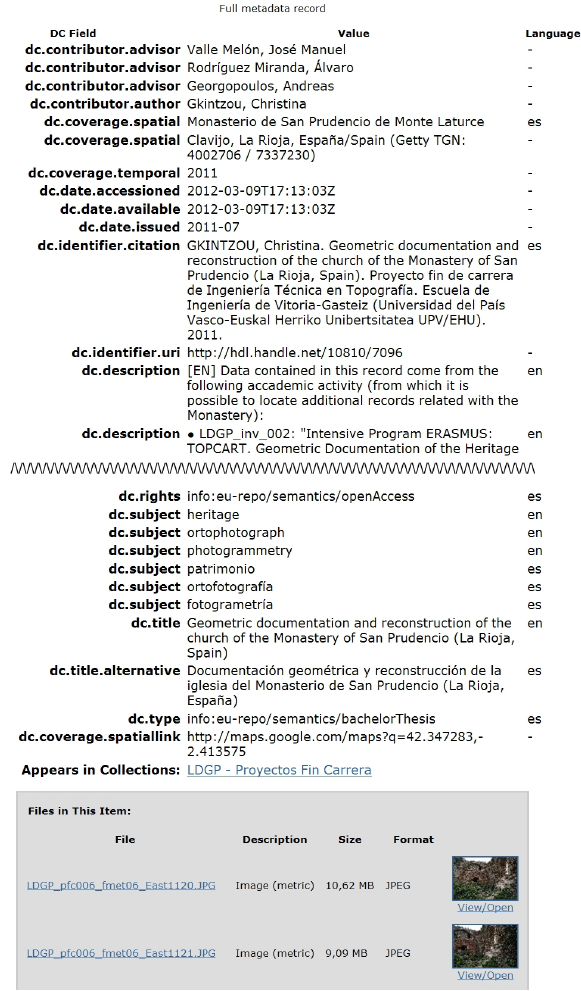
Figure 6. Part of the metadata included in a record from the University of the Basque Country’s repository (http://hdl.handle.net/10810/7096 20 Jun.